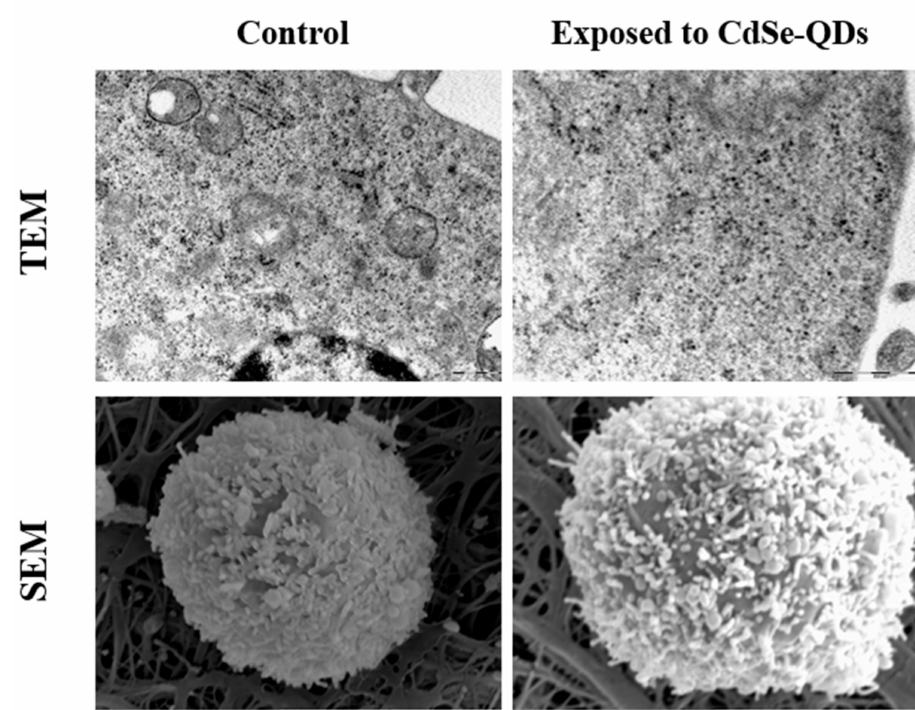
Figure 4. The T98G human glioblastoma cells visualized by TEM and SEM. T98G cells were exposed to 40 µ g/mL of CdSe-QDs as described in Section 4.4 and then processed for the electronic microscopy assessment as set out in Section 4.6 according to the performing facility’s internal protocols. A second independent culture yielded similar results. The TEM pictures were obtained both at 37,000 × . The SEM pictures were obtained at 8500 × (control) and at 8000 ×